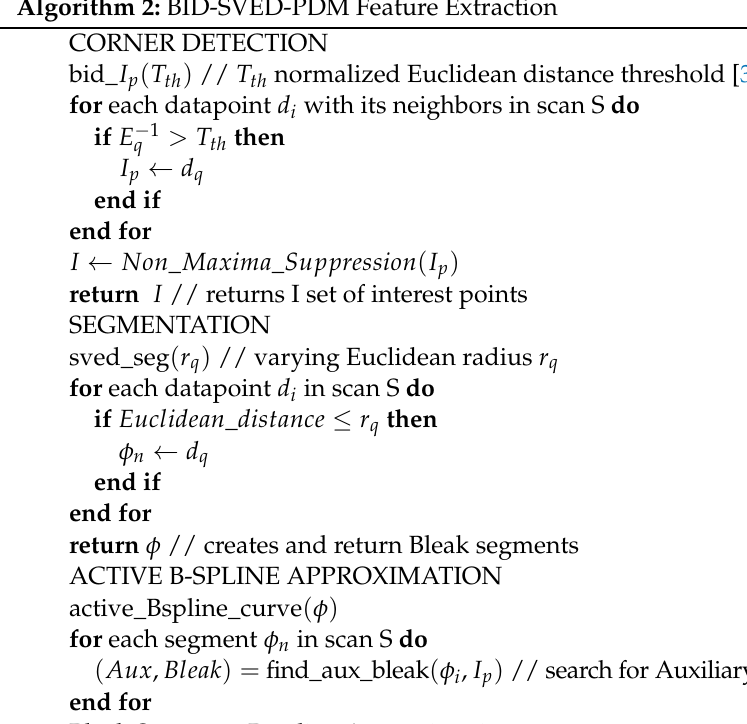
Algorithm 2: BID-SVED-PDM Feature Extraction CORNER